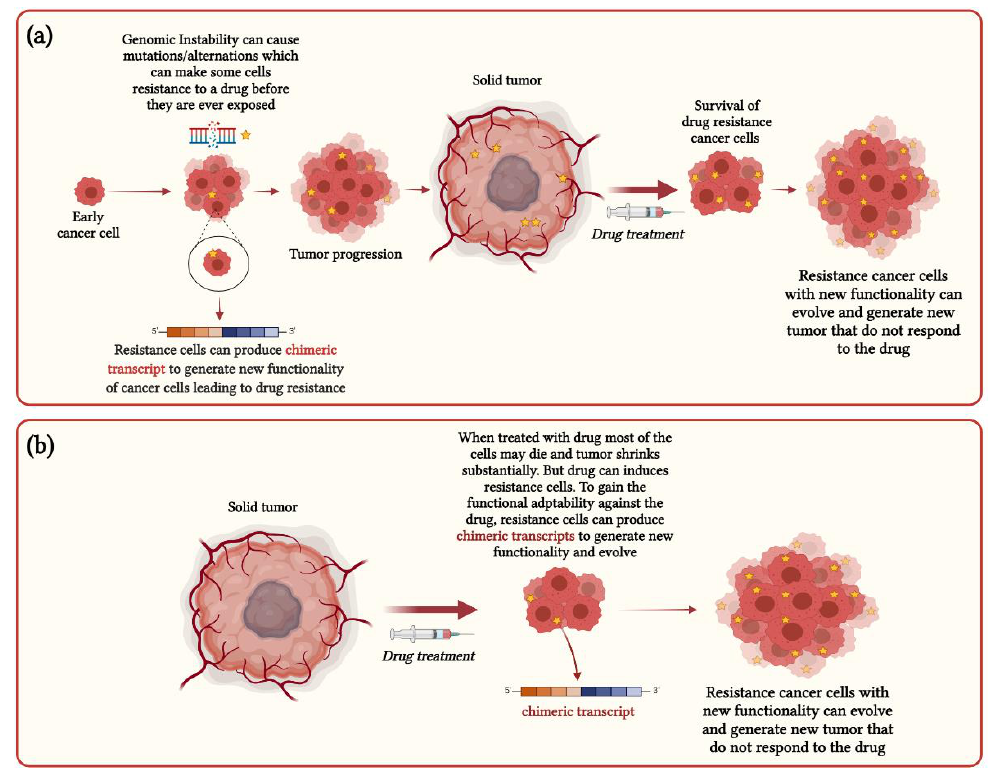
Figure 2. Functional impact of chimeric RNAs in cancer heterogeneity and drug resistance: ( a ) functional model for chimeric RNAs generated at the early stage of cancers; ( b ) functional model for chimeric RNAs generated at the later stage of cancers.